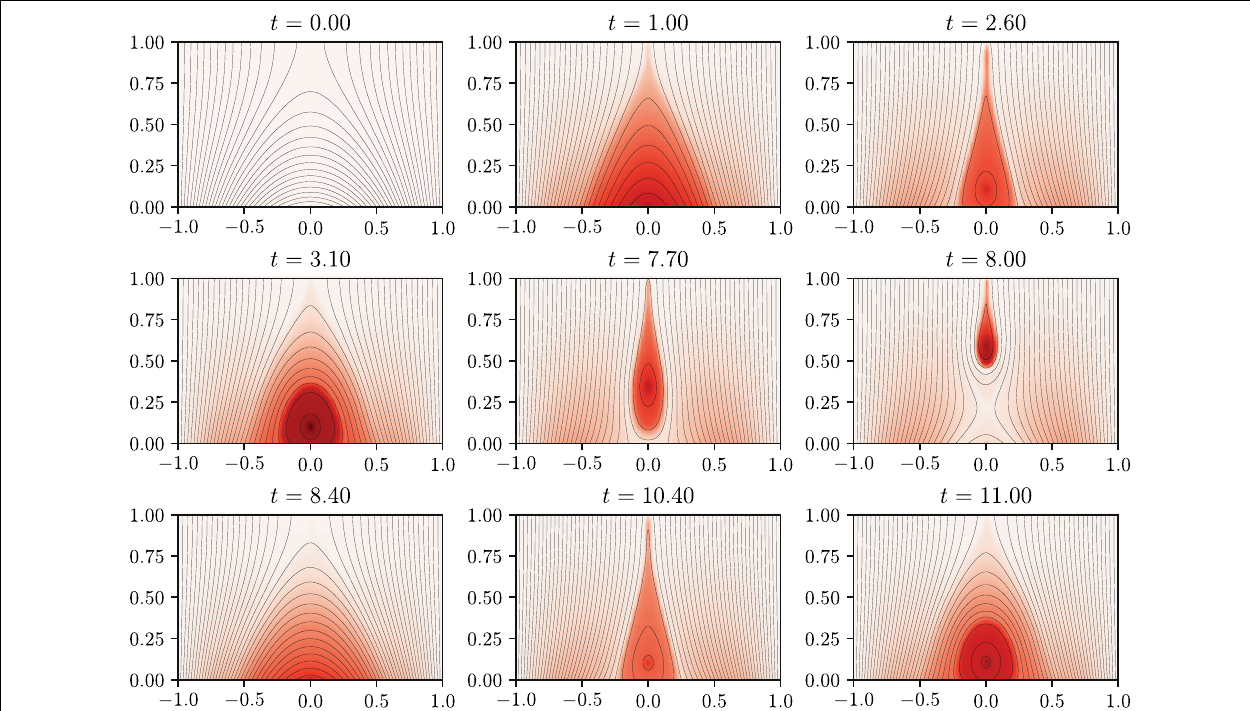
FIGURE 5 | Snapshots showing the formation of a flux rope and its subsequent eruption at time t = 8. This is followed by the formation of a second flux rope, which experiences an arcade eruption at t = 15.8, before the process repeats. The black lines are magnetic field lines projected onto the ( x , z ) plane, and the heatmap represents the magnetic field strength into the page (in the y direction). In this simulation, η 0 = 7 × 10 −3 and ν 0 =